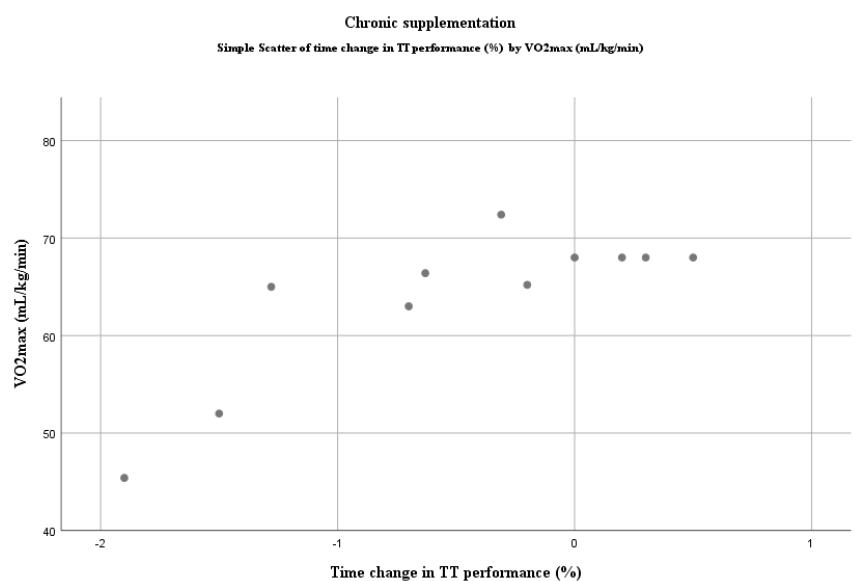
Figure 3. Relationship between VO 2max and DN ergogenicity in TT tests: chronic supplementation protocol. Negative values in time change represent improvement as the task was finished in less time.